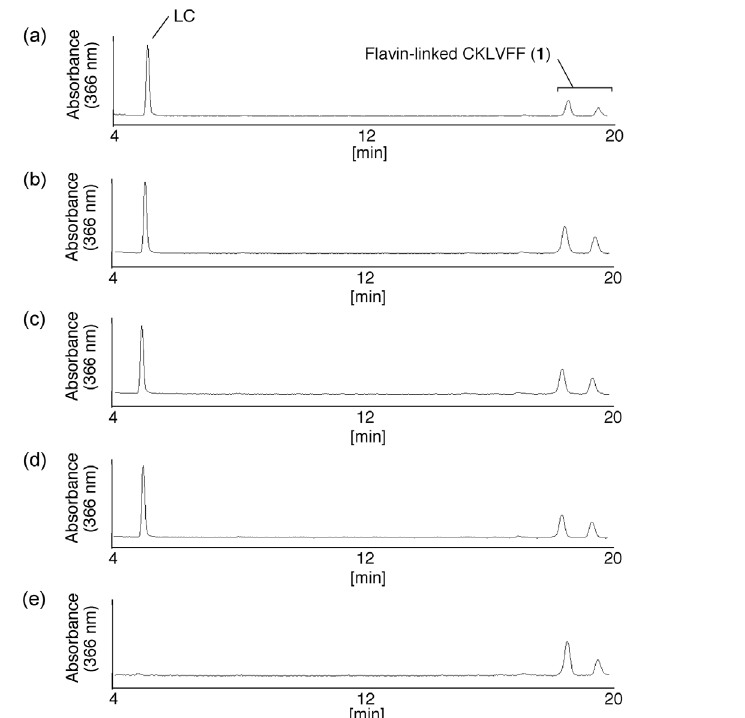
4.6 mm) eluted with a solvent mixture of 10 mM TEAA (pH 7), 25%–35% CH min, at a flow rate of 1.0 mL/min and monitored by absorption at 366